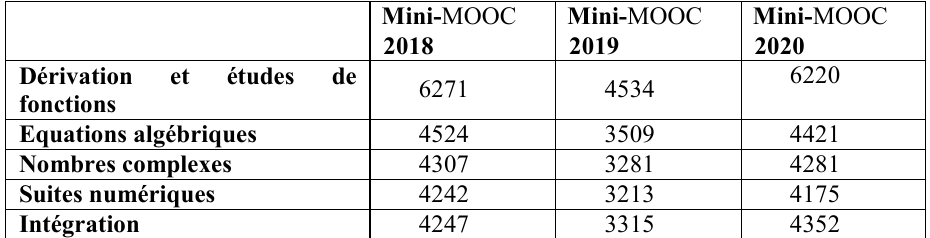
Tableau 2. Nombres d’inscrits pour les session Mini-MOOC.